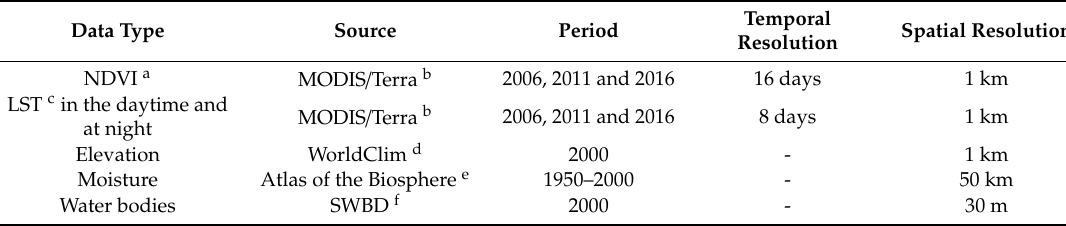
Table 1. Summary of environmental and climatic data sources